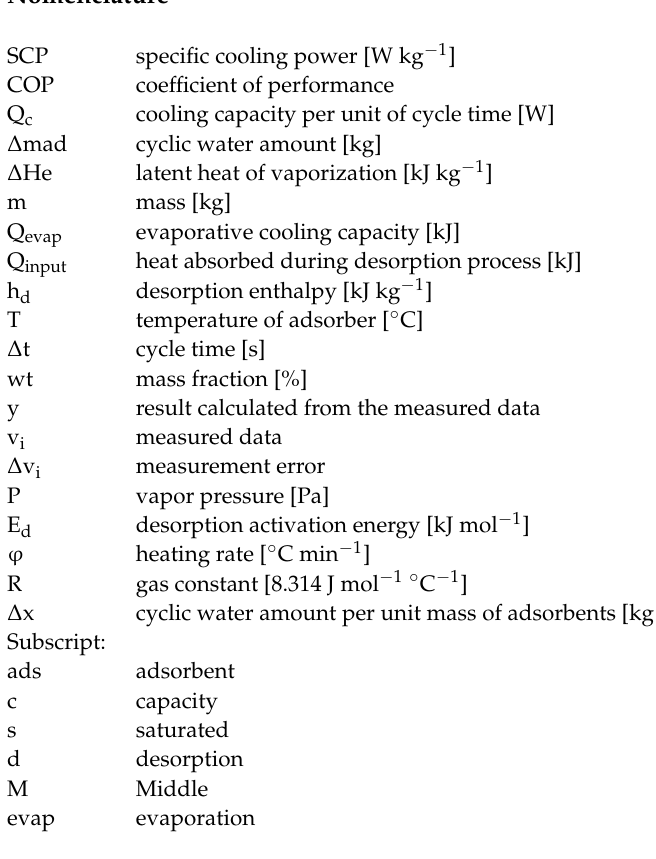
composite, Figure S2: Adsorption rate curves of water on MIL-101 and MIL-101/20%FLG composite, Figure S3: TG-DTA curves of water on MIL-101/20%FLG composite, Figure S4: XRD pattern (a), SEM image (b) and Raman spectra (c) of FLG, Figure S5: Effect of adsorption time on cooling capacity and cooling power of MIL-101-water working pair, Figure S6: Effect of desorption time on cooling capacity (a) and cooling power (b) of MIL-101-water working